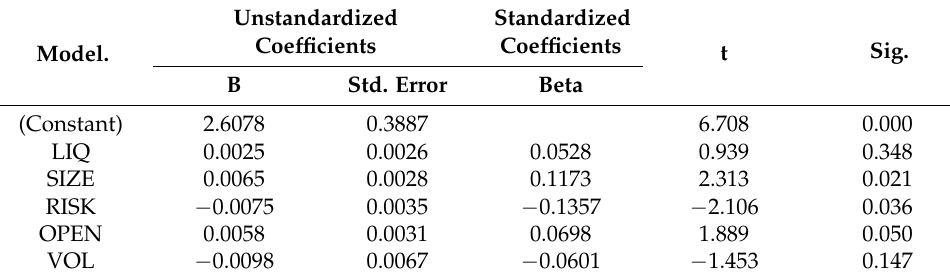
Table 6. Results of the multiple linear